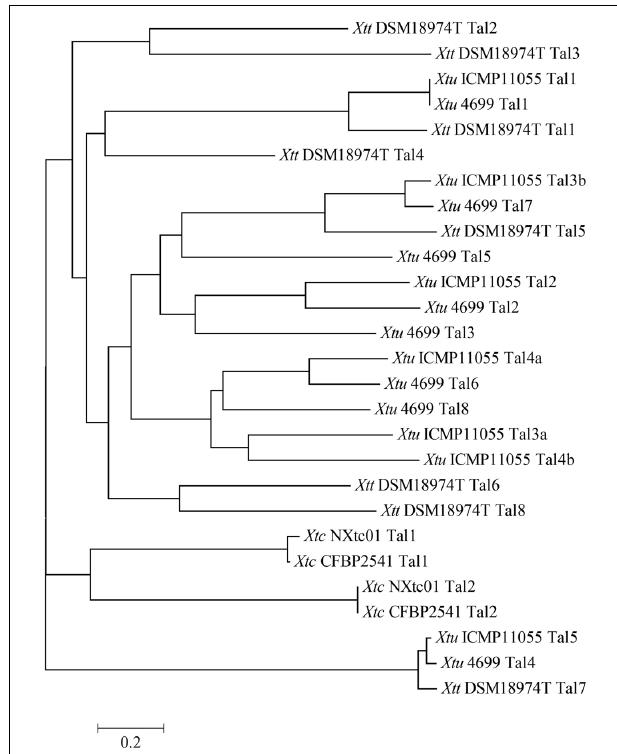
FIGURE 4 | Phylogenetic tree based on TALEs repeat arrangement alignments. DisTAL was used to build tree for a set of 27 TAL effector sequences from 5 different X. translucens strains. TALEs were classified into 17 groups showing the relationship of Xtc NXtc01 to several other X. translucens strains published previously (Pesce et al., 2015; Jaenicke et al., 2016; Peng et al., 2016; Falahi Charkhabi et al., 2017). Scale is shown below the tree.